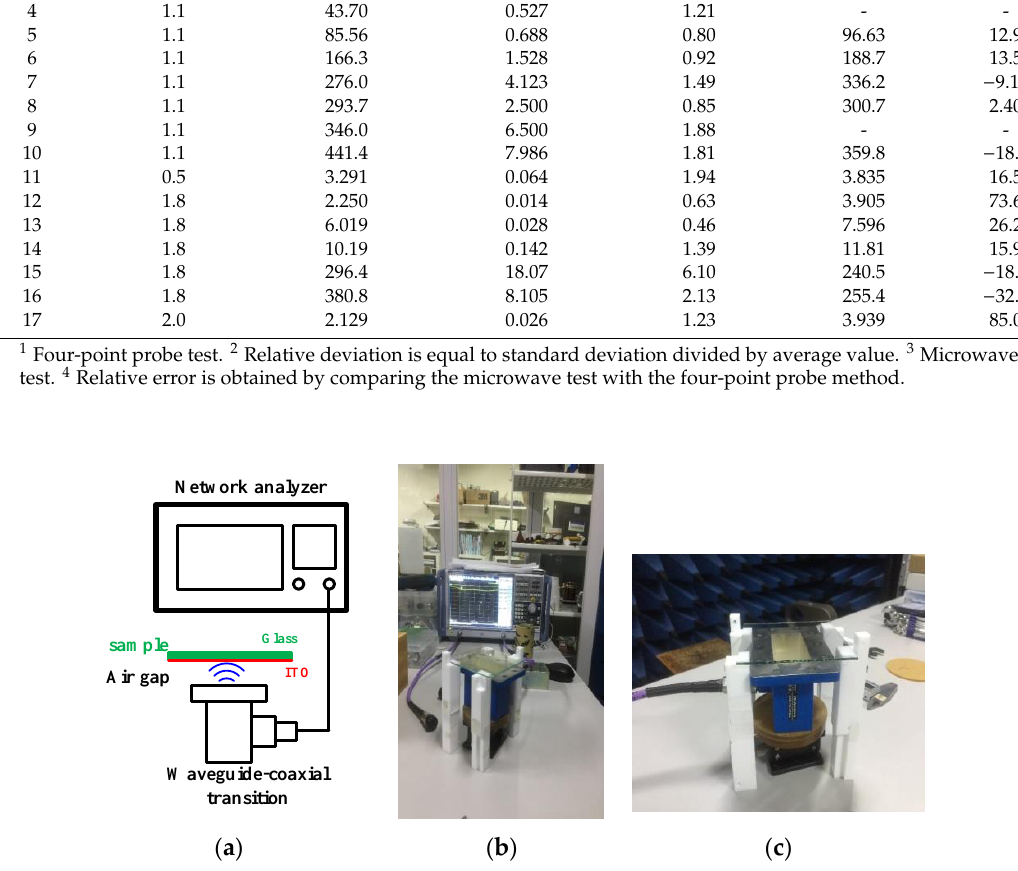
Figure 1. ( a ) Schematic of measurement setup; ( b ) photo of whole setup; ( c ) photo of waveguide sensor with sample.